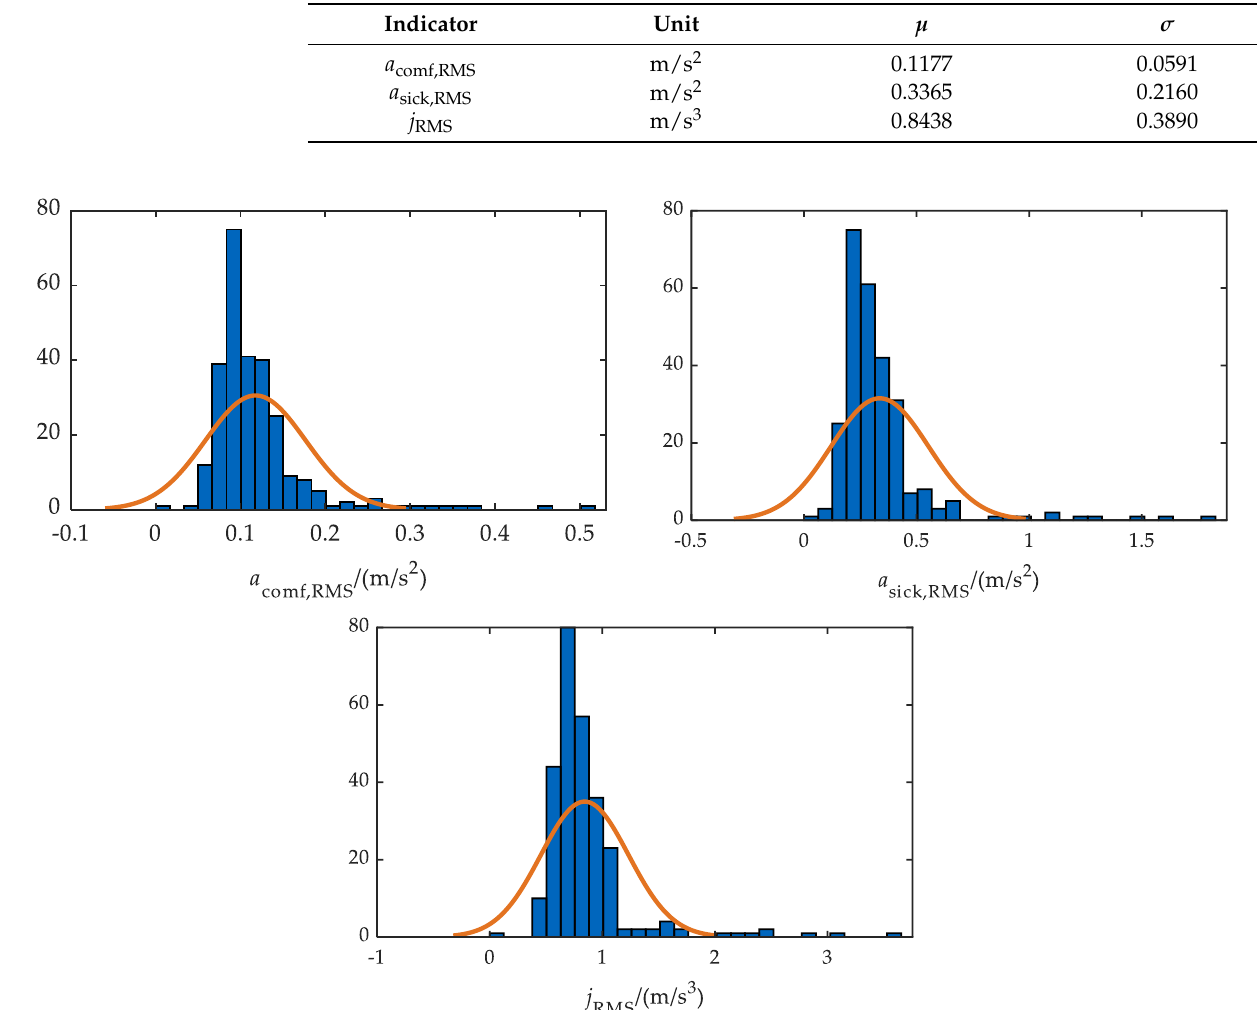
Figure 4. Distributions of comfort indicators in driving data.